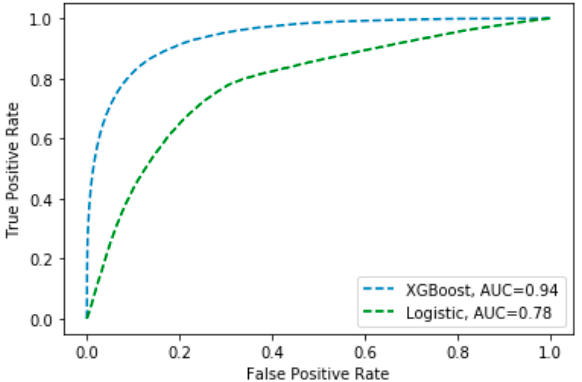
each feature, SHAP values were calculated by comparing the predictions without the fea- ture with the predictions including the feature (for example, [68]). Each dot in each feature represents the feature’s effect on the prediction in a specific observation. The color of each Figure 5. ROC curves—weighted wildfire occurrence classification. ROC curves of the highest observation indicates the value of the variable in that observation, and its position on the performing ML model and a logistic regression as a benchmark accuracy. The full results are horizontal axis indicates its effect on the model output. For clarity of viewing the figure, presented in Table 3. The figure refers to the models which include wildfire history variables; a similar 5000 observations were randomly chosen from the entire dataset. figure for models without the wildfire history variables is presented in Appendix A (Figure A3).